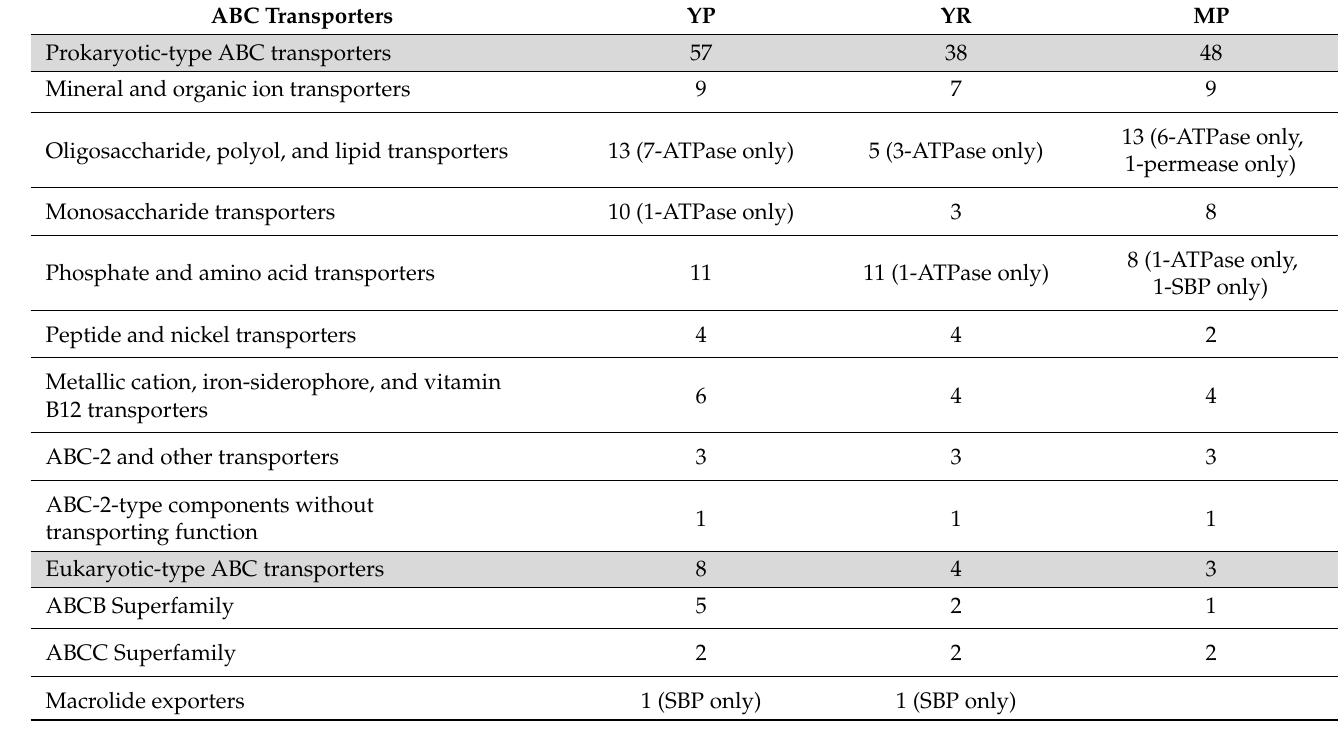
Table 3. ABC transporters in the studied